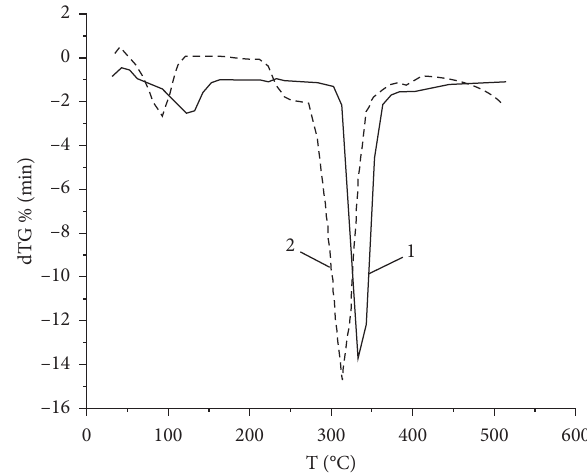
Figure 5: Differential thermographic curves (DTG) of β -CD (1) and β -CD :VD 3 (2:1) (2) at a constant heating rate of 10 deg/min in a nitrogen